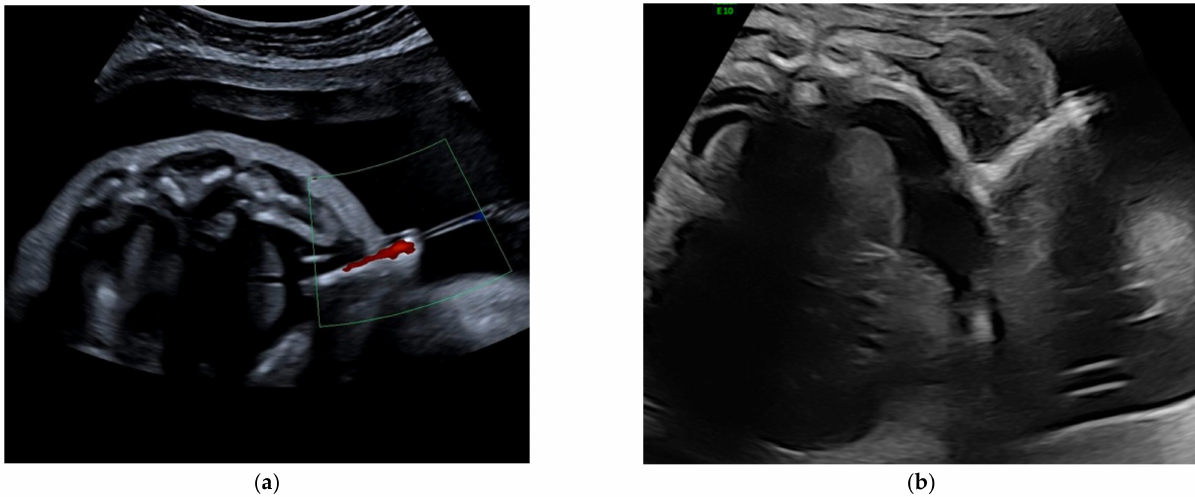
Figure 2. ( a ) Correct position of a Somatex shunt (axial view). Outward flow through the shunt is demonstrated by color Doppler. ( b ) Intracutaneous dislocation of a Somatex shunt in a fetus with massive skin edema on an axial view of the thorax. The inner end of the shunt is not reaching the pleural